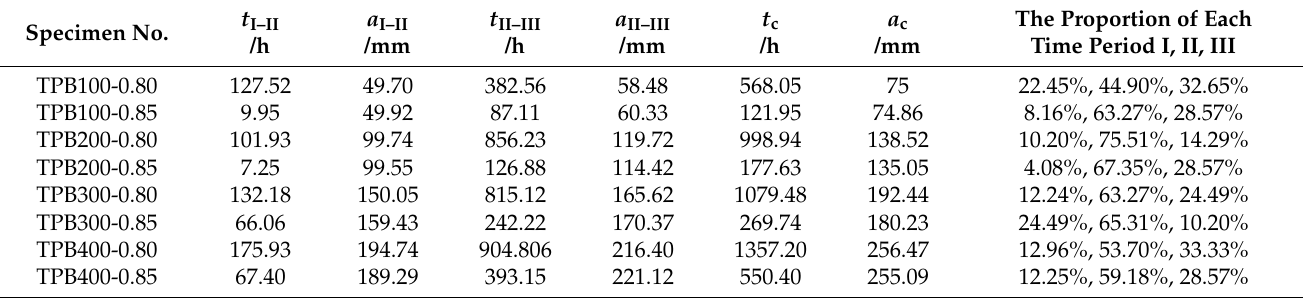
Table 1. Information of each stage of a–t curve.